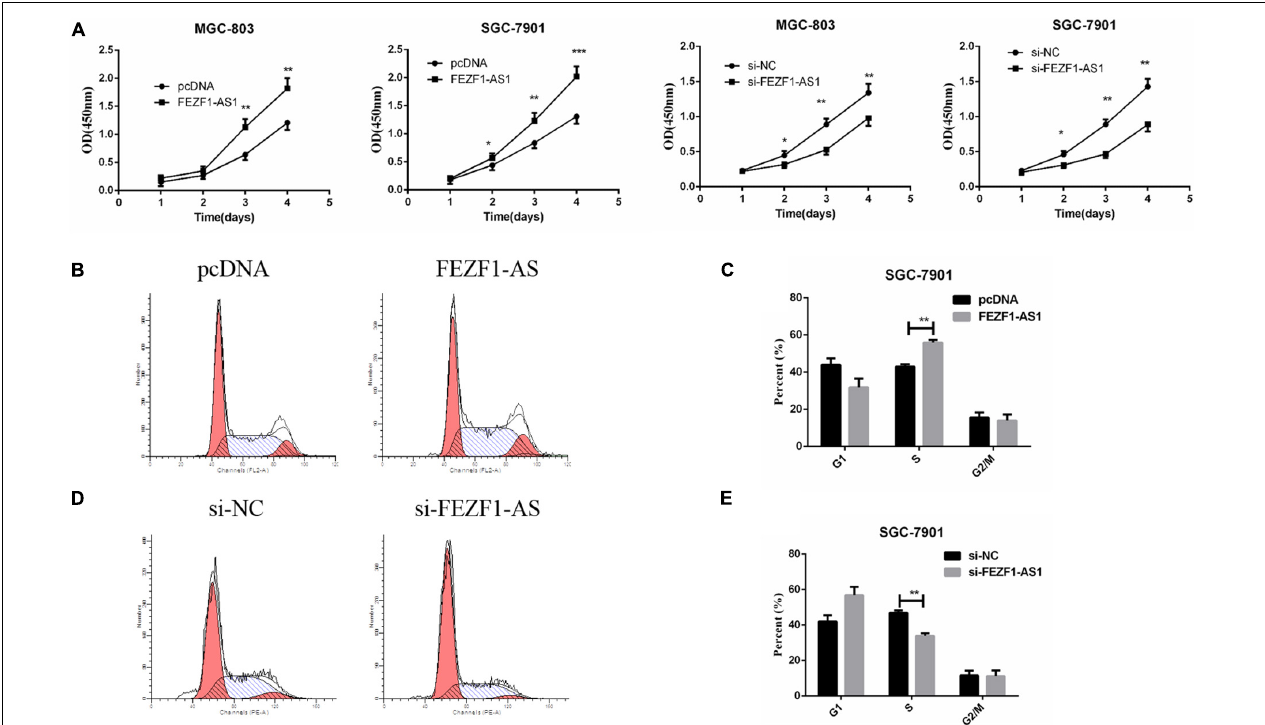
FIGURE 2 | FEZF1-AS1 promoted GC cell proliferation in vitro . (A) Effects of FEZF1-AS1 overexpression or knockdown on GC cell proliferation measured by CCK-8 assay. (B,C) FACS analysis on the effects of FEZF1-AS1 overexpression on cell cycle in SGC-7901 cells. (D,E) FACS analysis on the effects of FEZF1-AS1 knockdown on cell cycle in SGC-7901 cells. The results represented the mean ± SD of 3 independent experiments. * P < 0.05, ** P < 0.01, *** P < 0.001.